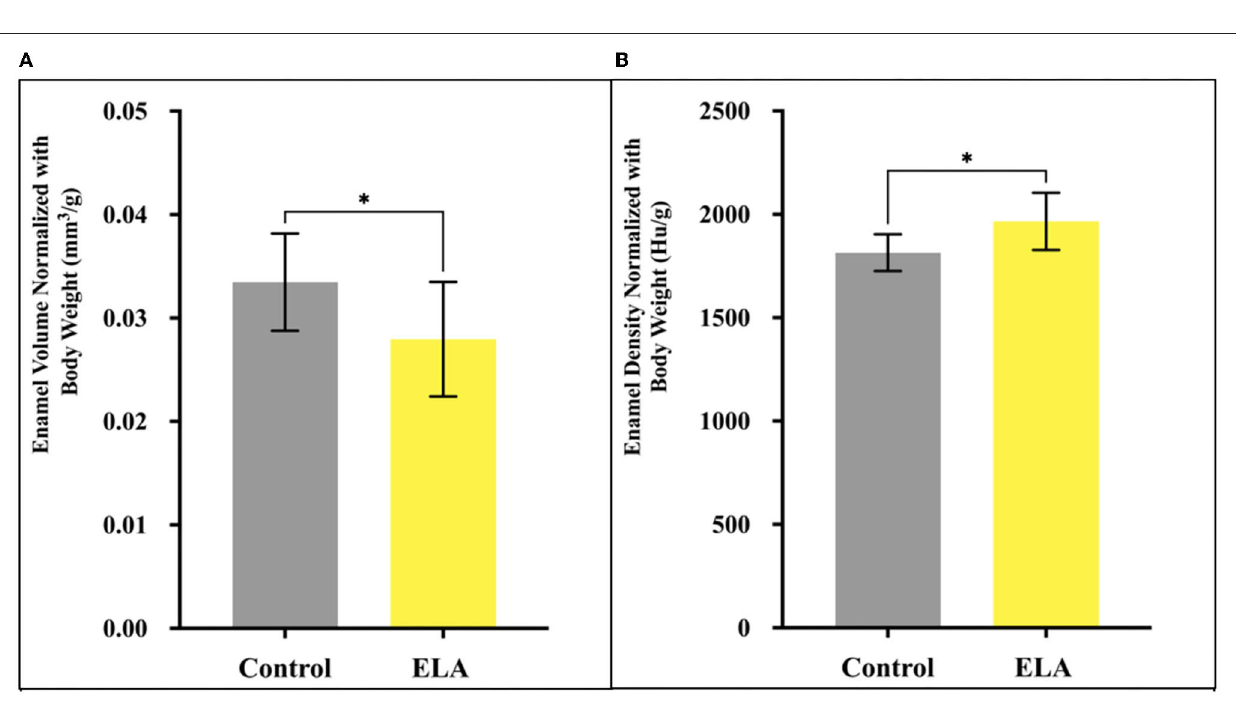
metalloproteinases, including MMP20, found primarily in the secretory stage, and KLK4, found primarily in the maturation stage, were also not differentially expressed in ELA as compared with control enamel